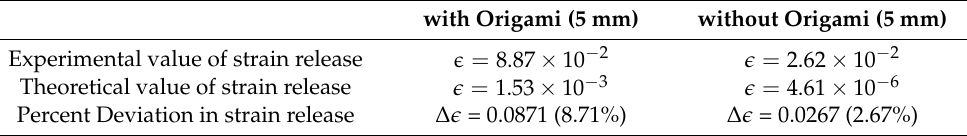
Table 7. Experimental and theoretical model of the beam (a) with origami, (b) without origami. with Origami (5 mm) without Origami (5 mm) Experimental value of strain release (cid:15) = 8.87 × 10 − 2 (cid:101) = 2.62 × 10 − 2 Theoretical value of strain release (cid:101) = 1.53 × 10 − 3 (cid:101) = 4.61 × 10 − 6 Percent Deviation in strain release ∆ (cid:101) = 0.0871 (8.71%) ∆ (cid:101) = 0.0267